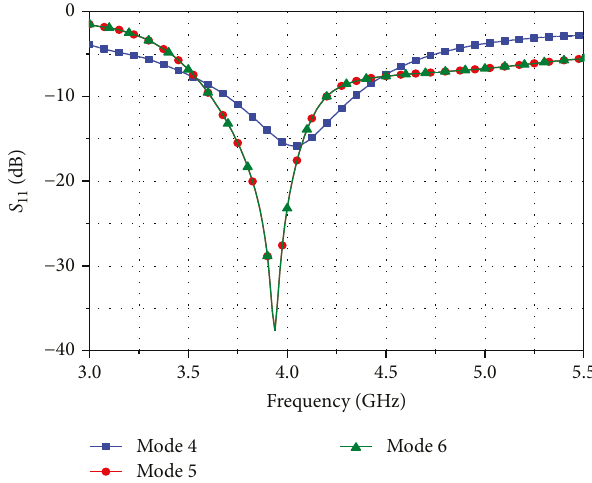
Figure 3: Simulated input re fl ection coe ffi cients in modes 4, 5, and